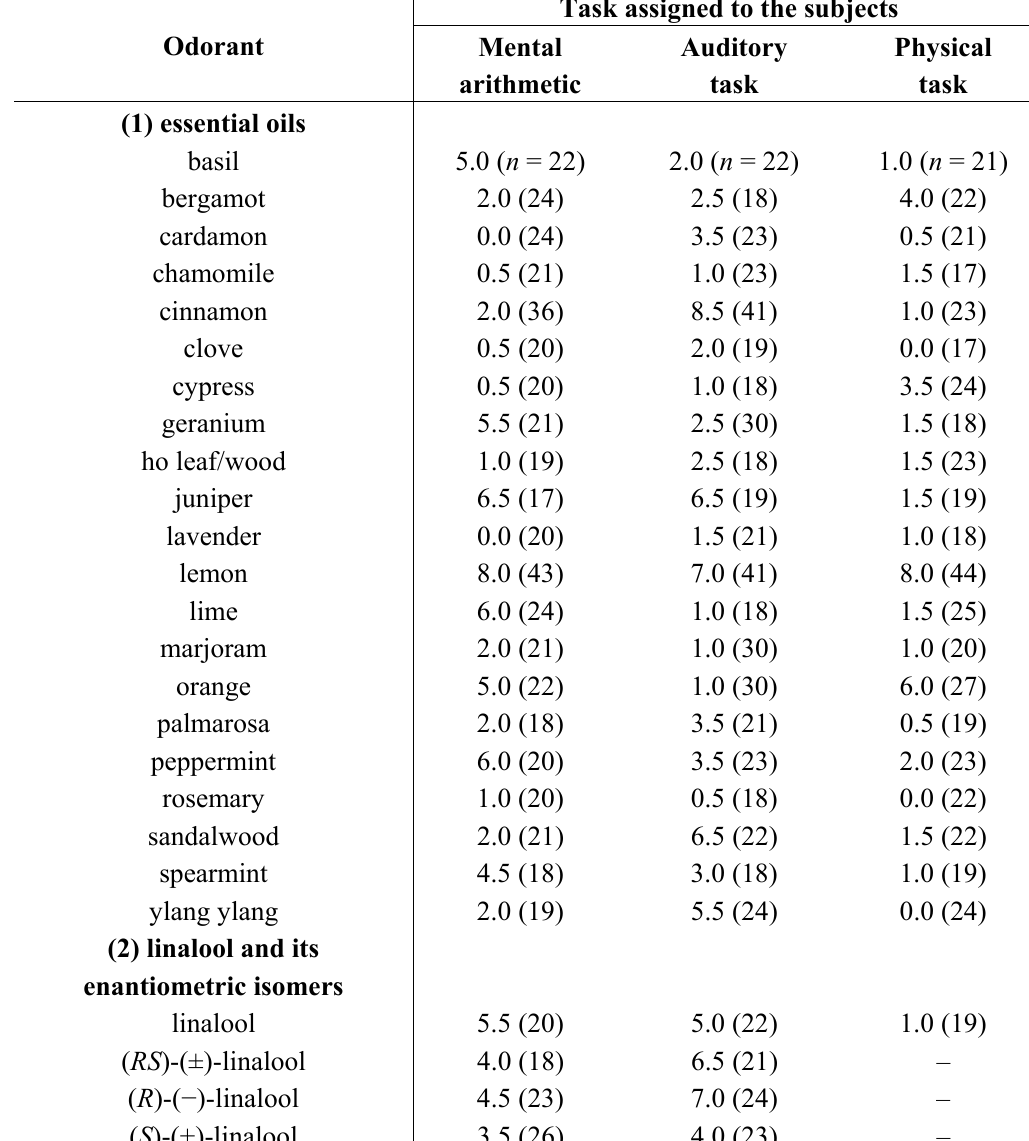
Table 1. Summary of the total significance scores (see text) resulting from statistical analysis on verbal (semantic) responses to odorant of the following 21 essential oils and linalool as well as its enantiometric